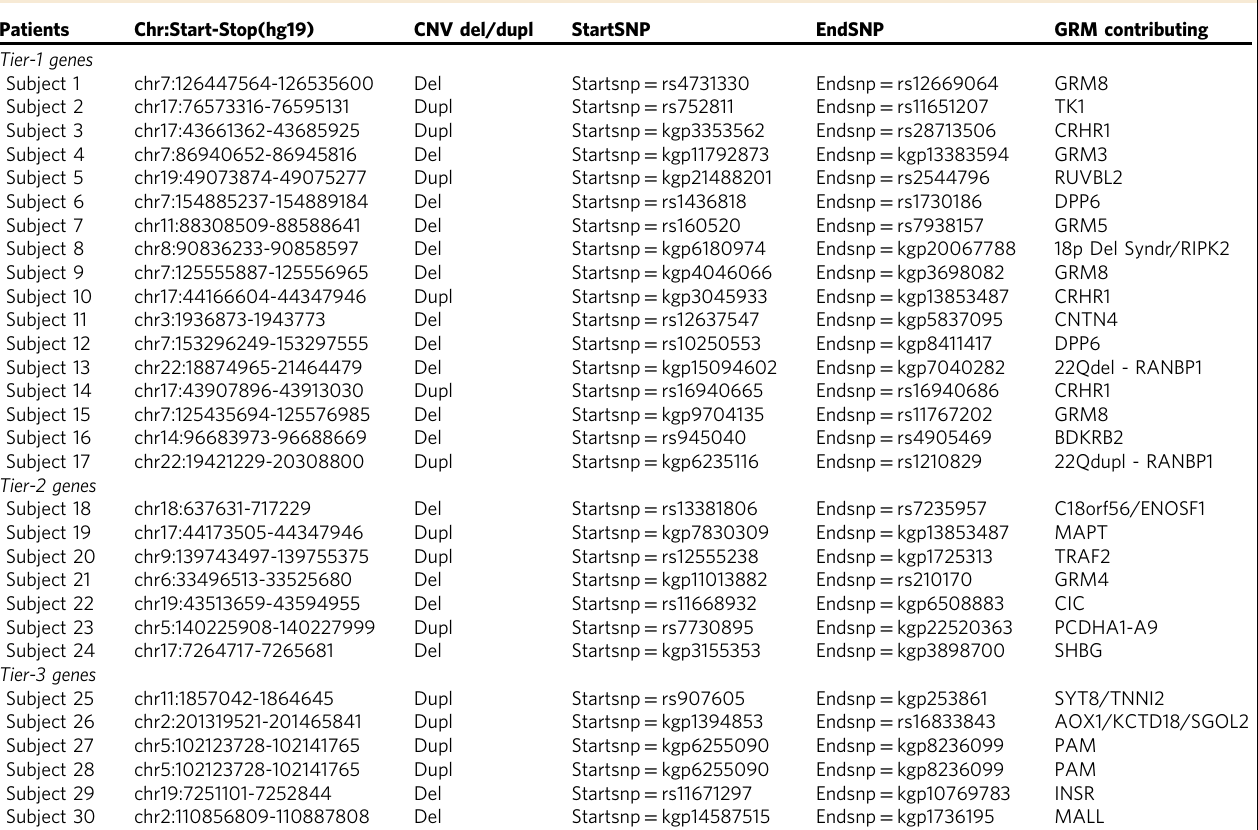
Table 5 mGluR gene network variants impacting enrolled patients Patients